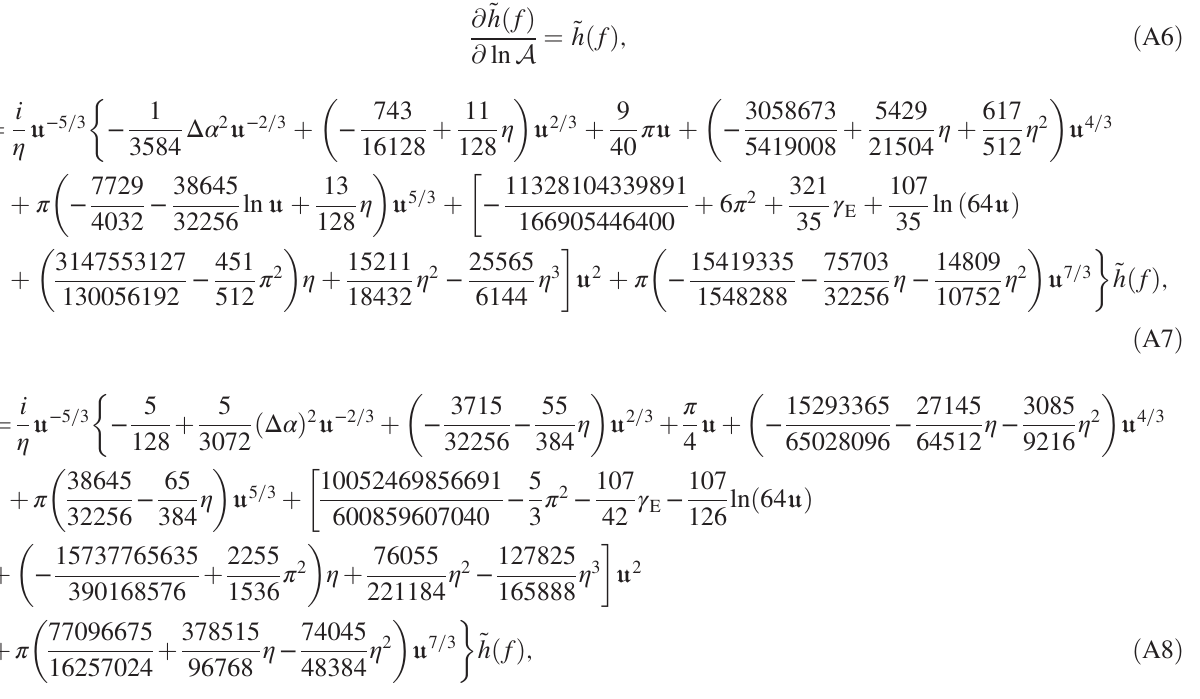
The mass at which NSs become ultrarelativistic, in this sense, depends on the EOS and can be read off from Fig. 7 as the mass at which the best constraint on j α j drops to zero. Recall that spontaneous scalarization stems from a large, positive source on the right-hand side of Eq. (3) that grows with φ . In ultrarelativistic stars, this source term becomes negative, causing the star to spontaneously “ descalarize. ” When placed in a binary system, ultrarelativistic NSs can dynamically scalarize, but the transition occurs very abruptly (e.g., the 1 . 9 M ⊙ − 1 . 9 M ⊙ system with the EOS WFF1 shown in Fig. 10). As the system scalarizes, the massive NSs transition to a state in which T is everywhere (cid:2) positive. Figure 11 depicts this transition in comparison to dynamical scalarization in less massive systems. The top ~ β — the PD equivalent of the quantity defined panel shows A in Eq. (22) — for 1 . 8 M ⊙ (solid line) and 1 . 9 M ⊙ (dashed line) stars with the EOS WFF1 plotted as a function of the scalar field. The highlighted points indicate the field at each NS in an equal-mass binary before (blue), during (red), and after (green) dynamical scalarization. The bottom panels depict the profile of T within each star at each of these (cid:2) points. The top panel of Fig. 11 demonstrates why dynamical scalarization occurs abruptly for ultrarelativistic